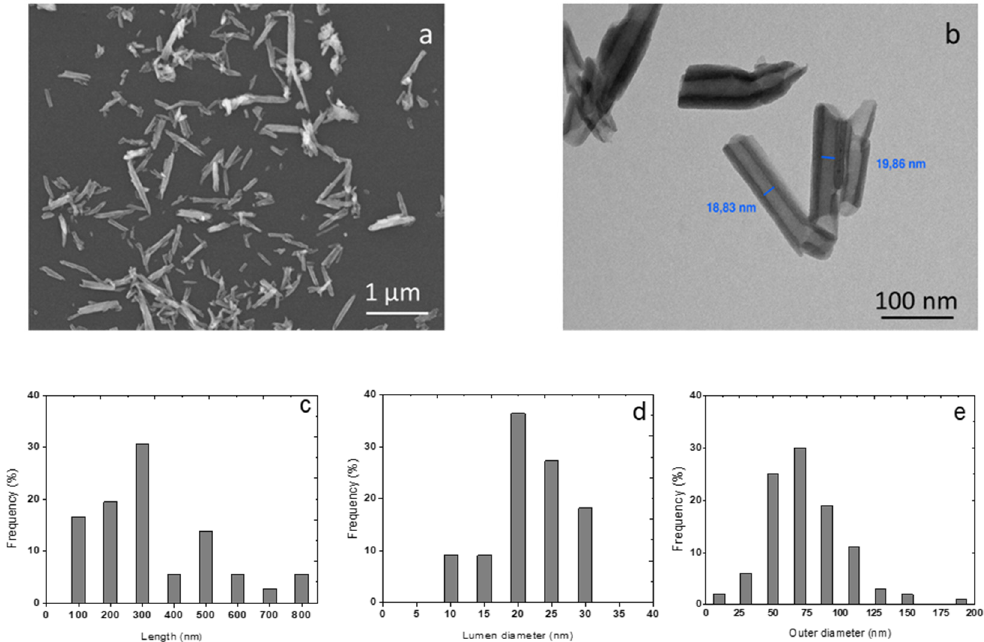
Figure 1. Scanning electron microscopy (SEM) ( a ) and transmission electron microscopy (TEM) micrographs of halloysite nanotubes (HNTs) ( b ) corresponding distribution histograms of length ( c ) lumen internal diameter ( d ) and outer diameter ( e ).